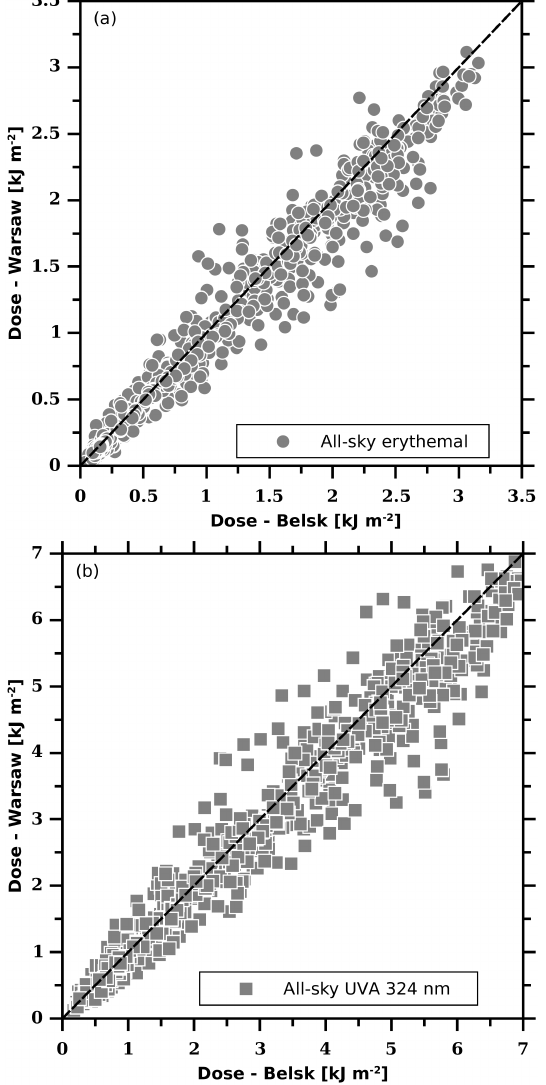
Figure 5. Scatter plot of partial daily doses (local noon − 3h, local noon + 3h) measured in Warsaw and Belsk: erythemal doses (a) and UVA (324nm) doses (b) .